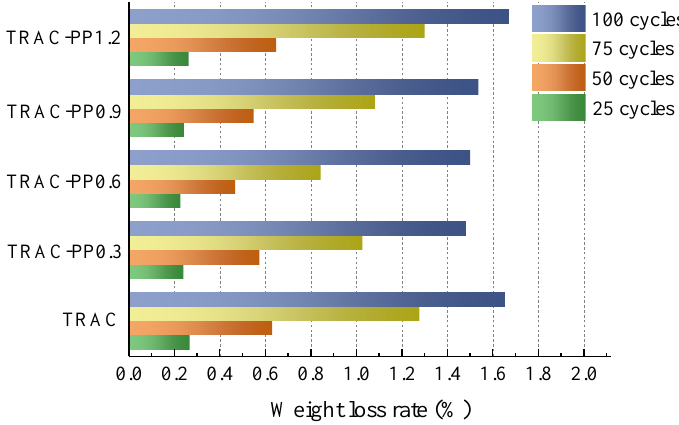
Figure 10. Weight loss rate of all mixtures during freeze–thaw